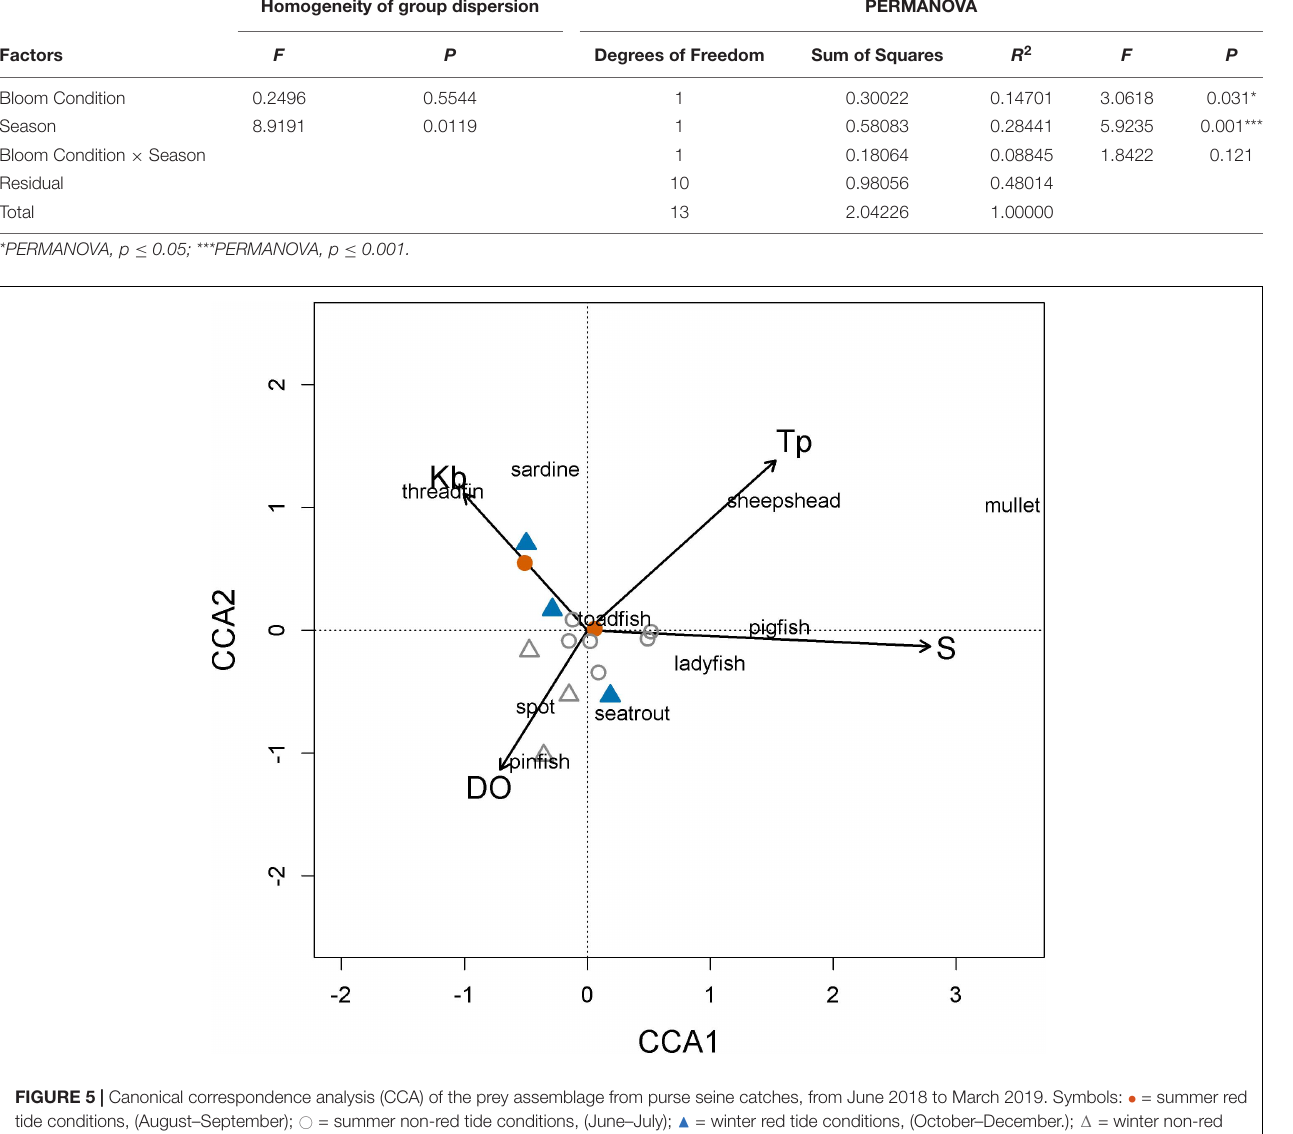
TABLE 2 | Homogeneity of group dispersion and permutational multivariate analysis of variance (PERMANOVA) results of prey community structure in the Sarasota Bay study area from June 2018 to March 2019, in relation to bloom condition and season. Homogeneity of group dispersion